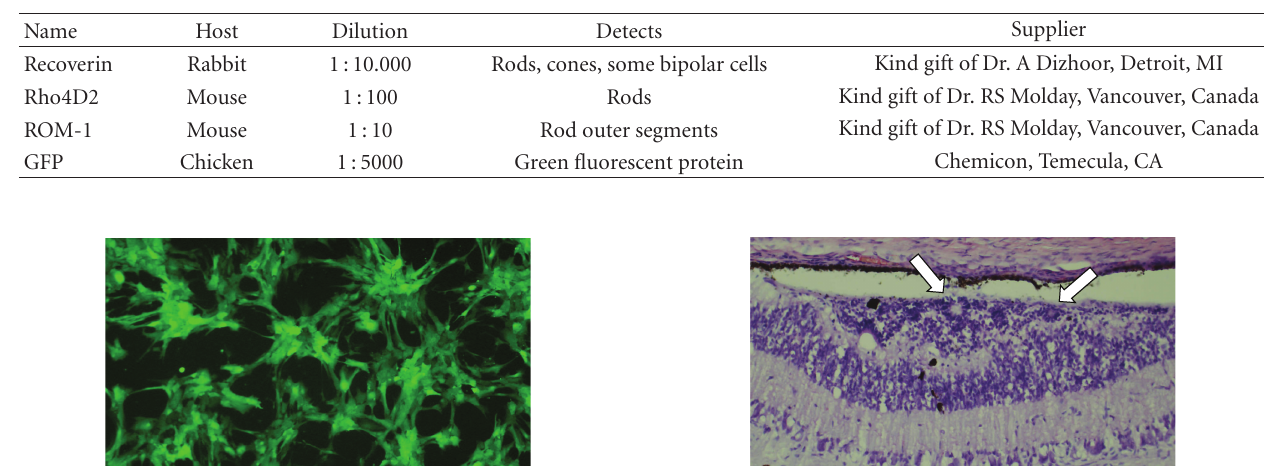
Table 1: Primary antibodies used for immunohistochemistry.